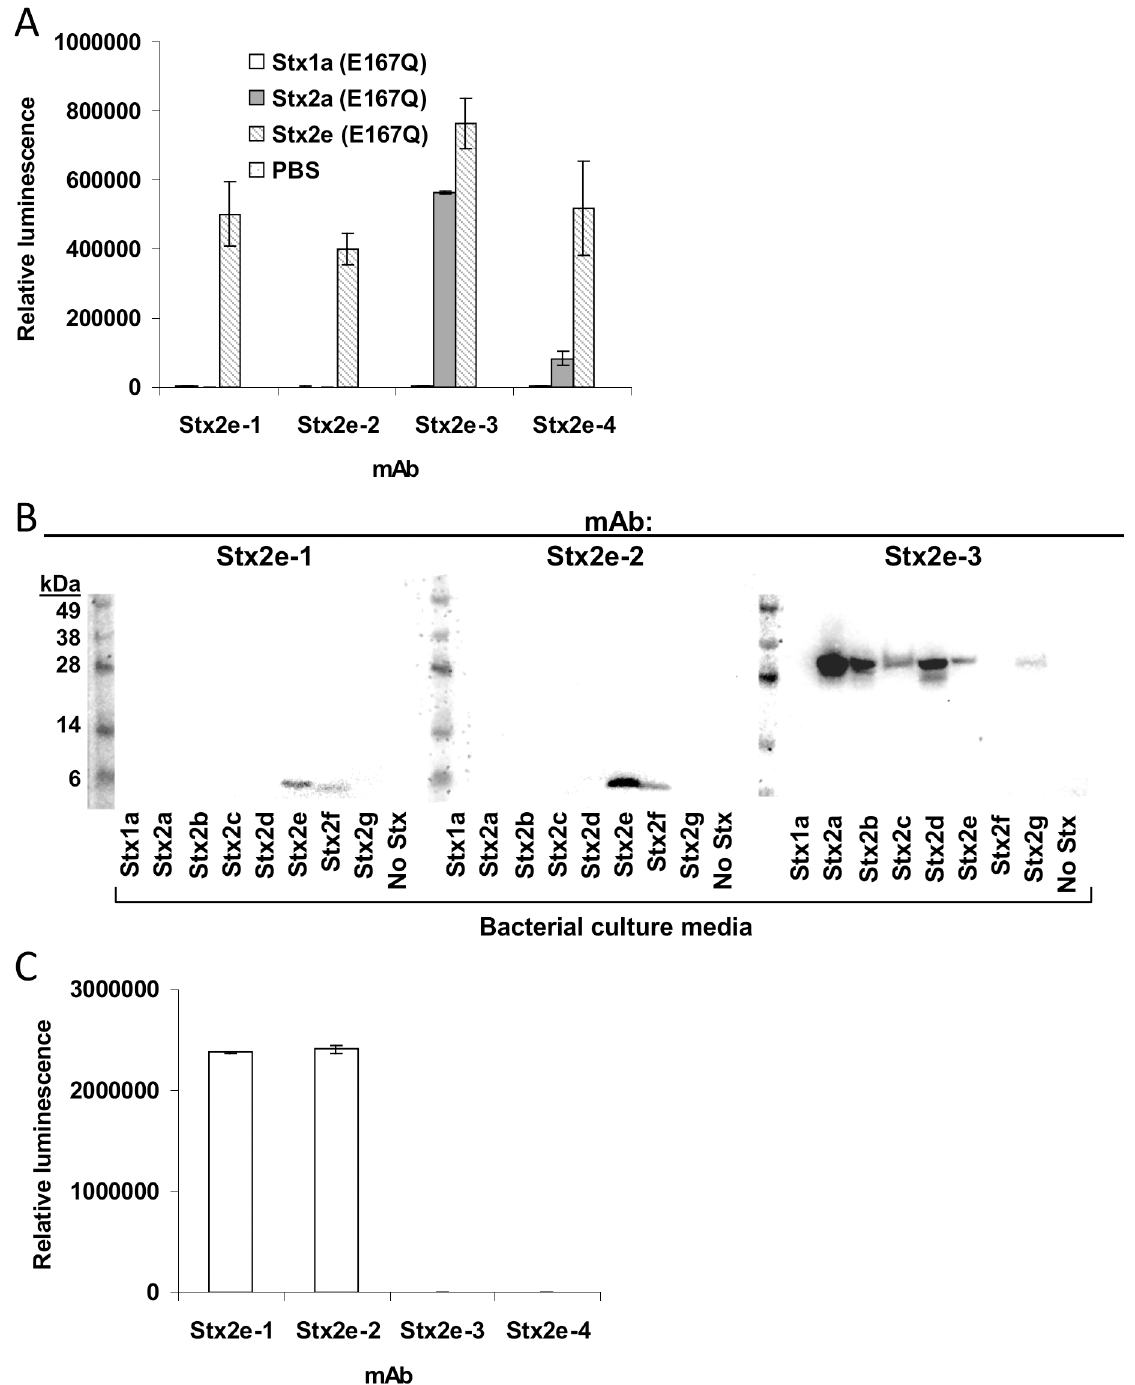
Fig 1. Stx2e antibody specificity. A) Direct ELISA using Stx2e mAbs and purified Stx toxoids. Stx2e mAb was added at 1 μ g/mL; purified toxoids at 100 ng/ mL. B) Western immunoblots for mAbs Stx2e-1, Stx2e-2, and Stx2e-3. Media from Stx-expressing strains were loaded at 10 μ L/lane. The “ No Stx ” sample contains media from an E . coli strain that doesn ’ t express Stx (ATCC 25922). C) Stx2e B subunit ELISA. Direct ELISA with Stx2e B subunit bound to ELISA plates at 1 μ g/mL. Antibodies were also used at 1 μ g/mL.